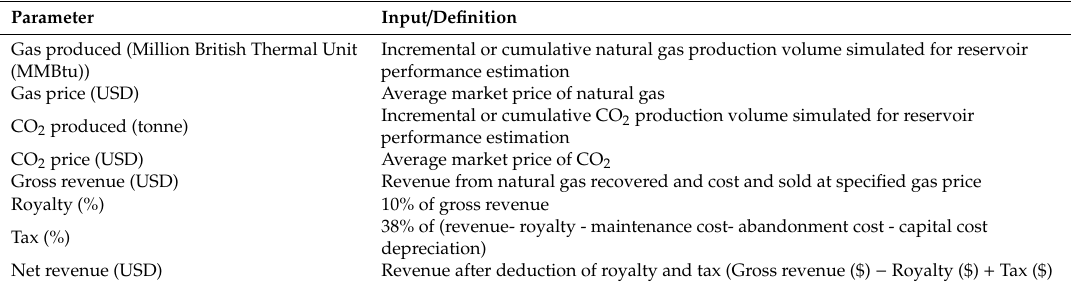
Table 2. Input and definition for parameters assessed in the revenue model.